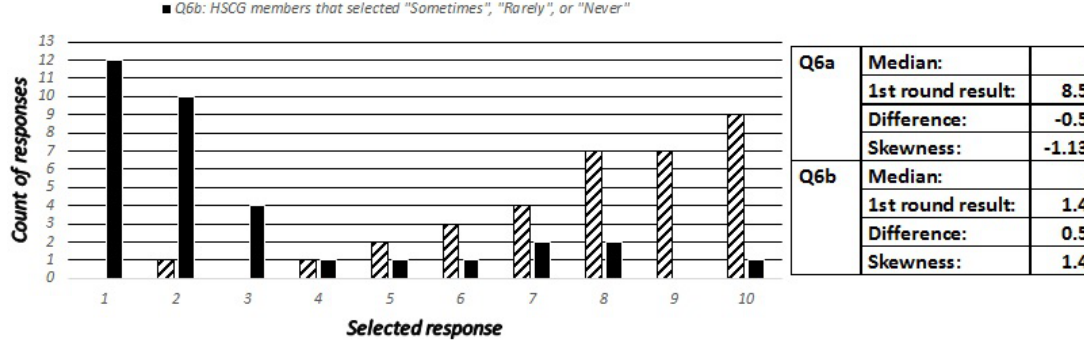
Figure 8. Expert predictions for question 6, only for HSCG (high-security competence